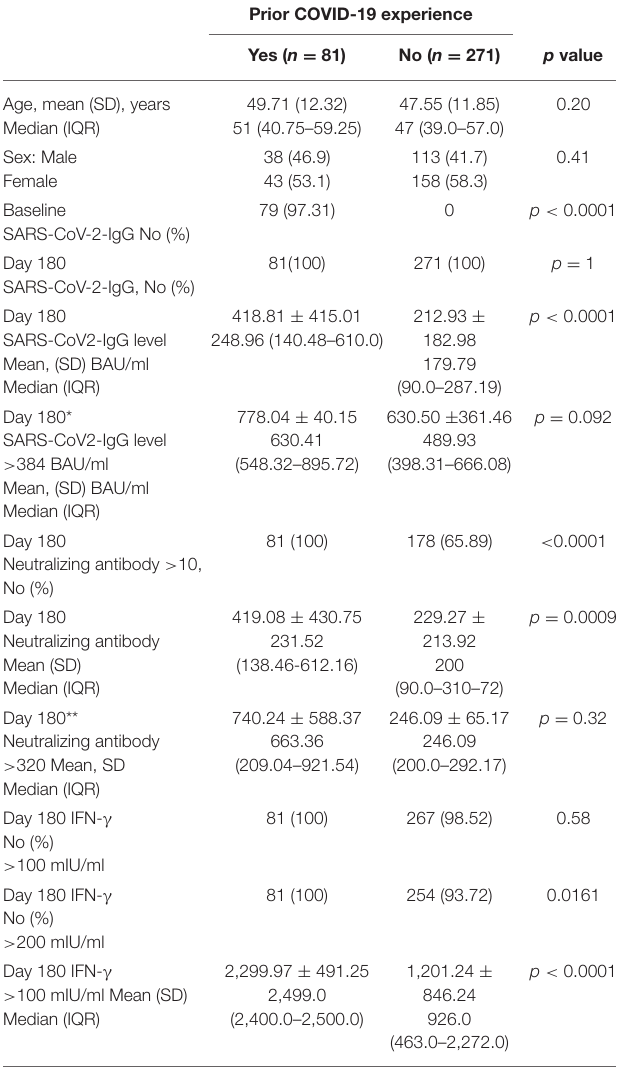
TABLE 1 | Baseline characteristics, antibody levels, neutralizing antibody titers, and IFN- γ concentration of vaccinated subjects.